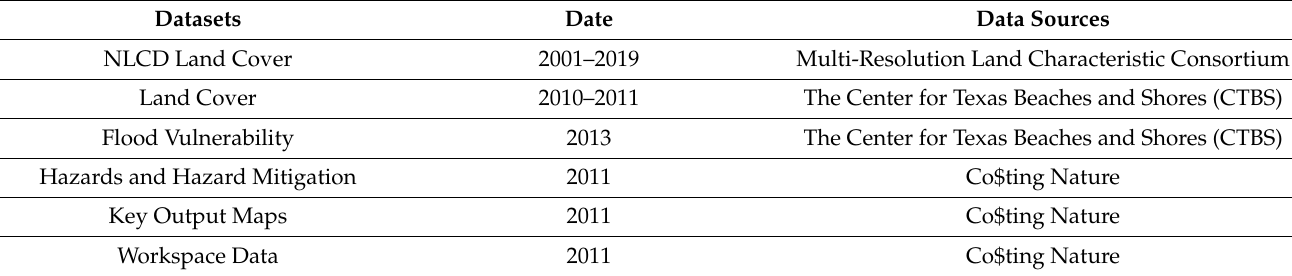
Figure 1. Map of the location of our study area based on Co$ting Nature’s tile extents (Figure credit: authors). Table 1. Primary datasets’ dates and sources for the layers used in preliminary research and background information towards creating the suitability model for our study